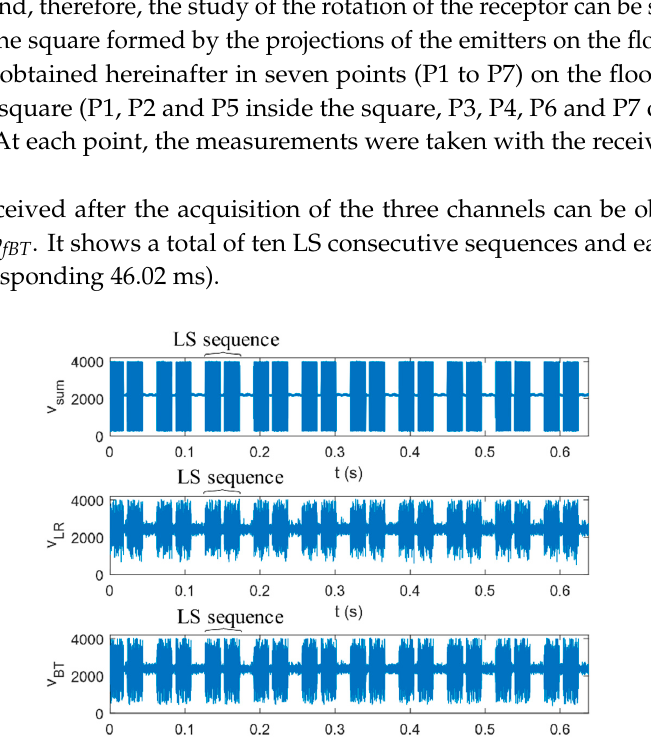
Figure 8. Real acquired signal (ten successive LS sequences) for each channel: v fsum , v fLR , v fBT .